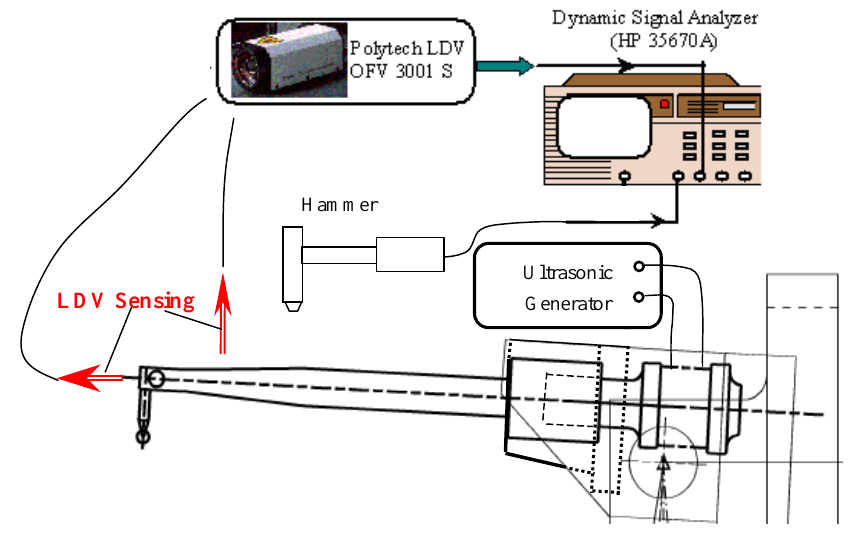
Figure 4. The experimental transducer testing system for FE model calibration.